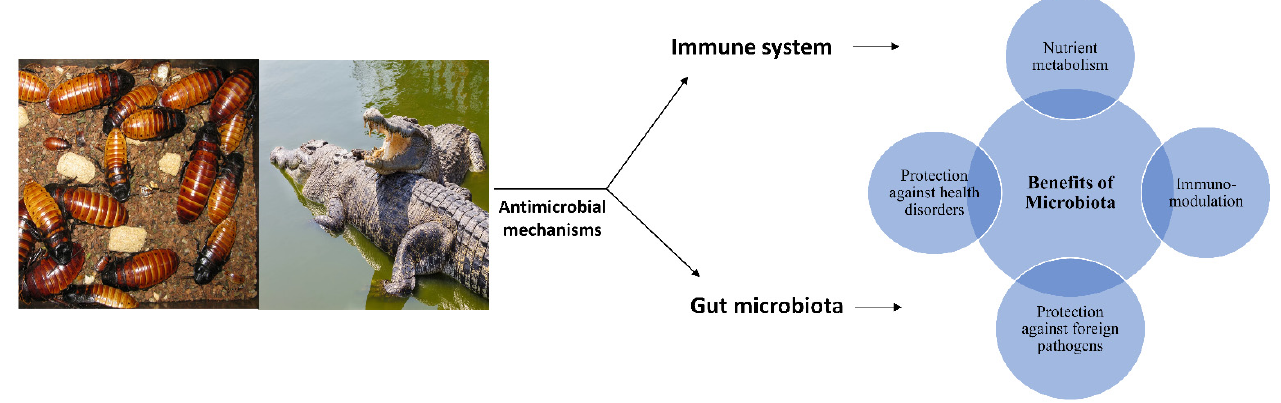
Figure 1. Gut bacteria of animals maybe a potential source of anti-infectives.